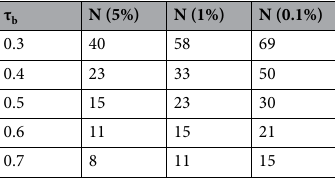
Table 3. Sample sizes needed for 80% power in testing Kendall’s τ b correlation coefficient at the 5%, 1%, and 0.1% levels (2-sided